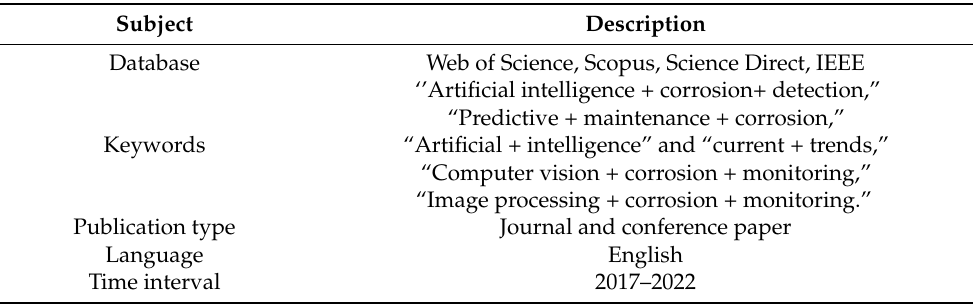
Table 1. Description of scope of bodies within the body of